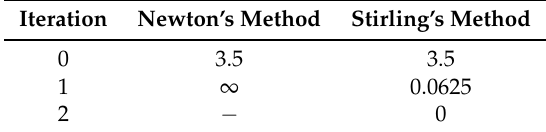
Table 2. Iteration of Newton’s and Stirling’s method with different starting